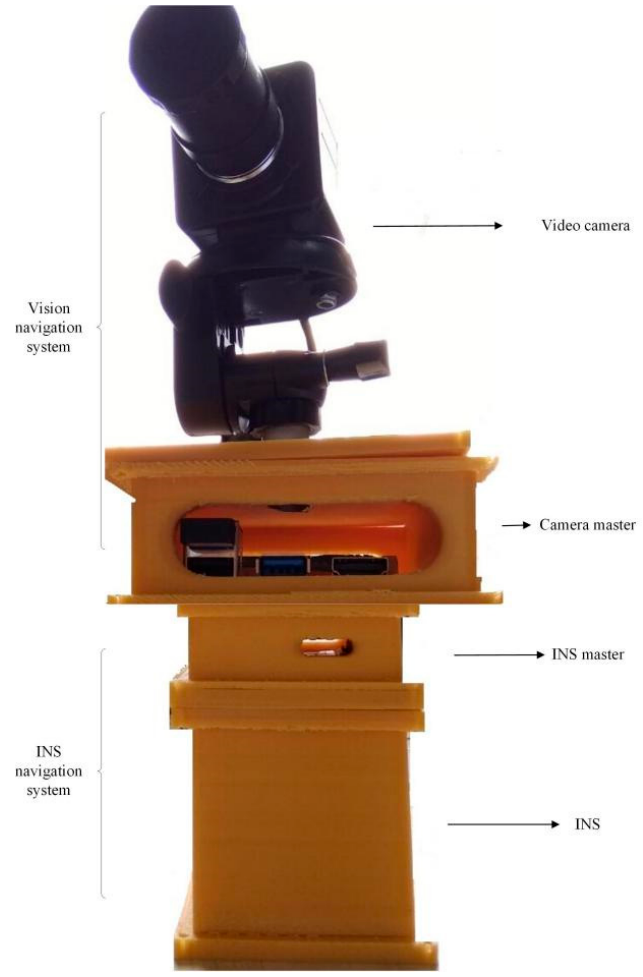
Figure 3. INS/vision navigation system. INS: Inertial navigation system.